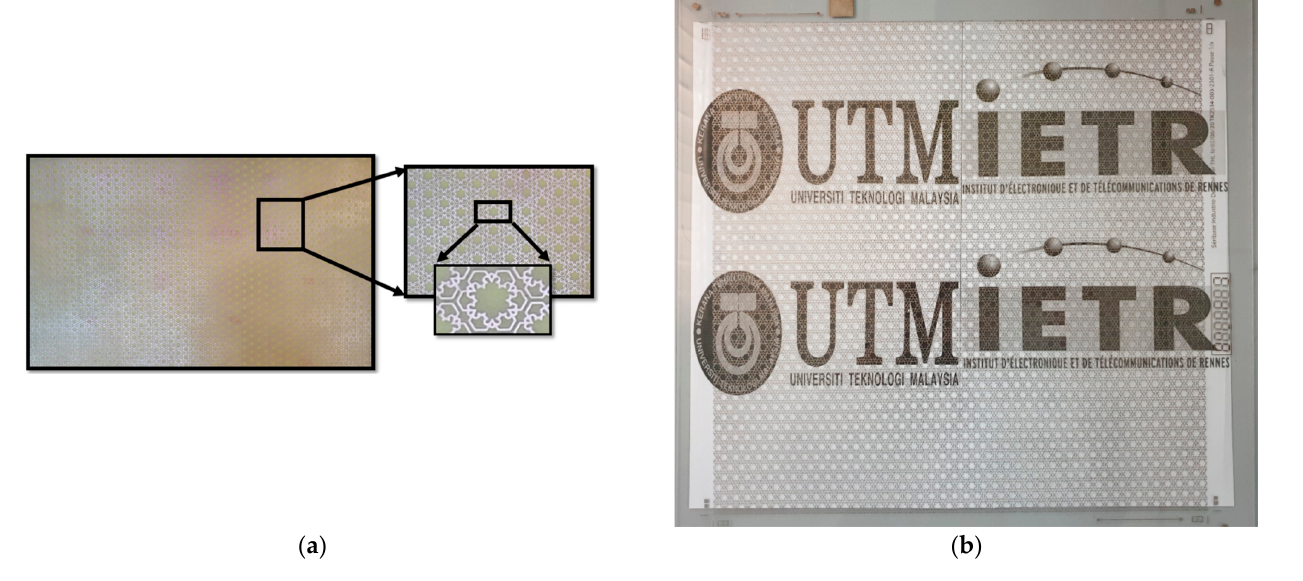
Figure 13. The fabricated prototype of MFSS on both substrates; ( a ) FR4 substrate (210 × 297 mm 2 ) and ( b ) polycarbonate substrate (300 × 300 mm 2 ).